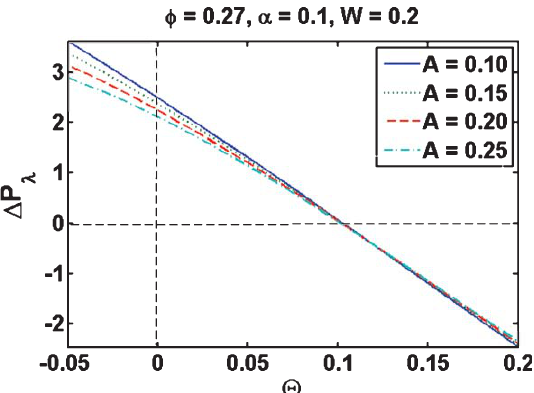
Fig. 15. Variation in (cid:12)P λ against (cid:10) for different values of fluid parameter ( A ).